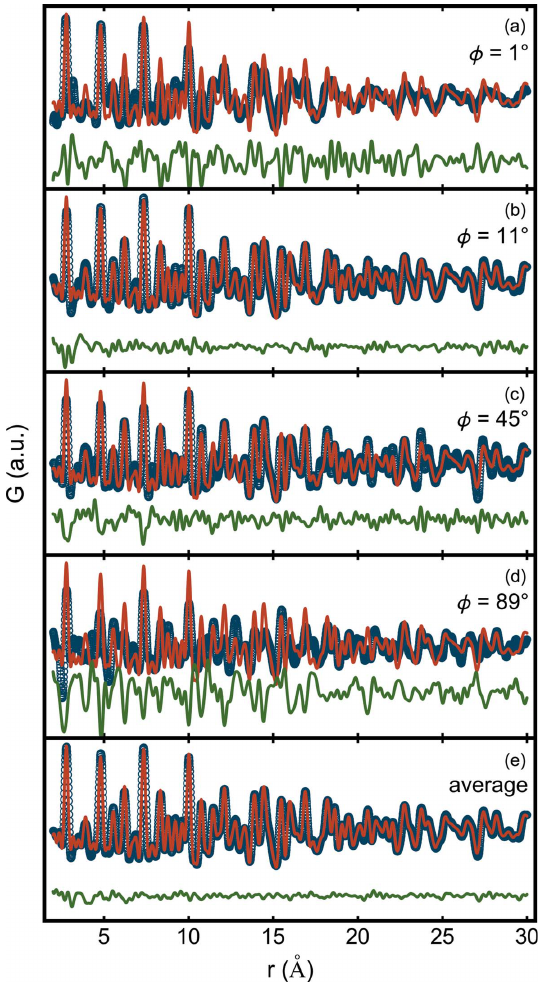
Figure 2 Comparison of measured and best-fit calculated PDFs for diffraction images taken at different sample orientations. The blue circles are the experimental PDFs for sample tilt angles (cid:3) = 1, 11, 45 and 89 (cid:3) , and from the average of the diffraction images from 1 to 89 (cid:3) . The red curves are the best-fit calculated PDFs from an untextured face-centred cubic model. The green curves are the difference between the calculated and measured PDFs. The PDFrefinement from the angle-averaged pattern yields a good result with R w = 13.5%. Among the single-angle PDFs, (cid:3) = 11 (cid:3) shows the best refinement result ( R w = 18.1%) and (cid:3) = 89 (cid:3) shows the worst result ( R w = 63.6%) (Fig.